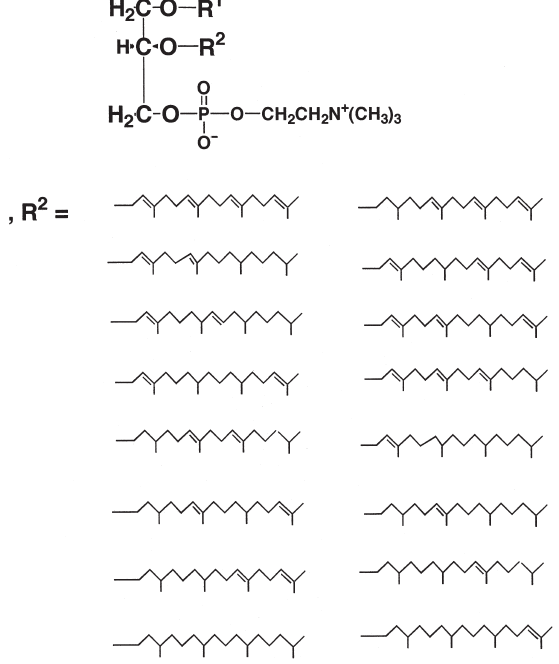
Figure 7. Possible structures of archaetidylcholine. Although the po- sitions of double bonds on the hydrocarbon chains are assumed to be at 2, 6, 10 and 14, the exact positions were not